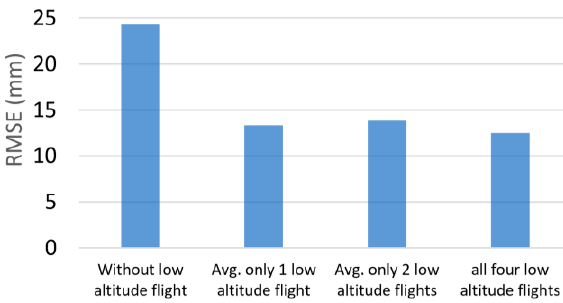
Figure 9: Analyzing the effect of number of low altitude flights on